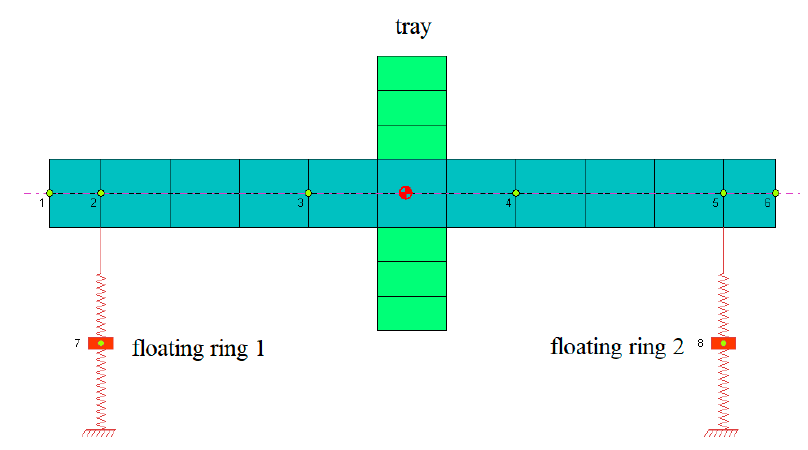
Figure 1. Dynamic finite-element model of the floating bearing-rotor system.